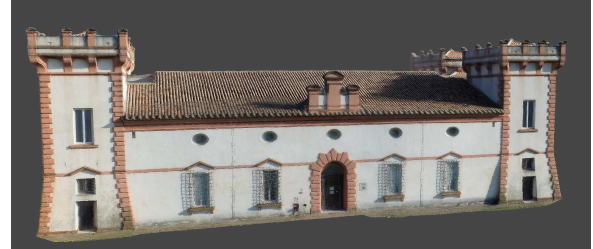
Figure 31: Front view of the textured model of the castle.